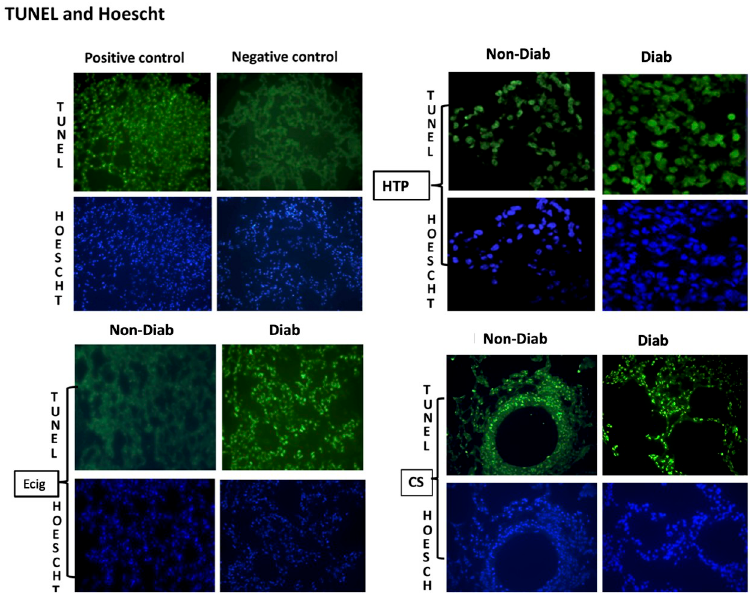
Fig 5. Cell death assessment. Terminal deoxynucleotidyltransferase-mediated dUTP nick-end labeling (TUNEL) and Hoechst staining of lung sections for Control, ECIG and CS from Non-Diabetic and diabetic mice. Significant increase in apoptotic activity was noted in ECIG and CS and exposed diabetic mice when compared to ECIG and CS Non- Diabetic mice respectively.